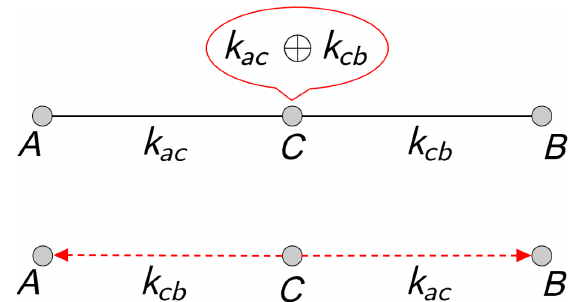
FIG. 3. Simple key flow. The top line shows the intermediary node C announcing the combined key k ac ⊕ k cb , which is shown in the top diagram. A and B may decode the keys k cb and k ac , respectively. Therefore, knowledge of k cb ( k ac ) flows to A ( B ) via k ac ( k cb ). This is depicted in the bottom